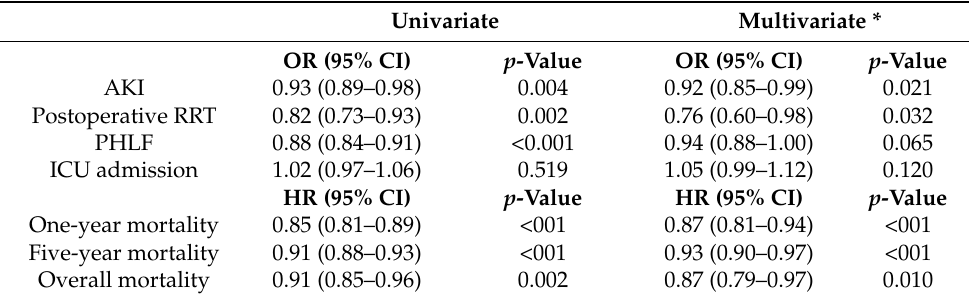
Table 5. AKI incidence and surgical outcomes adjusted by PNI.